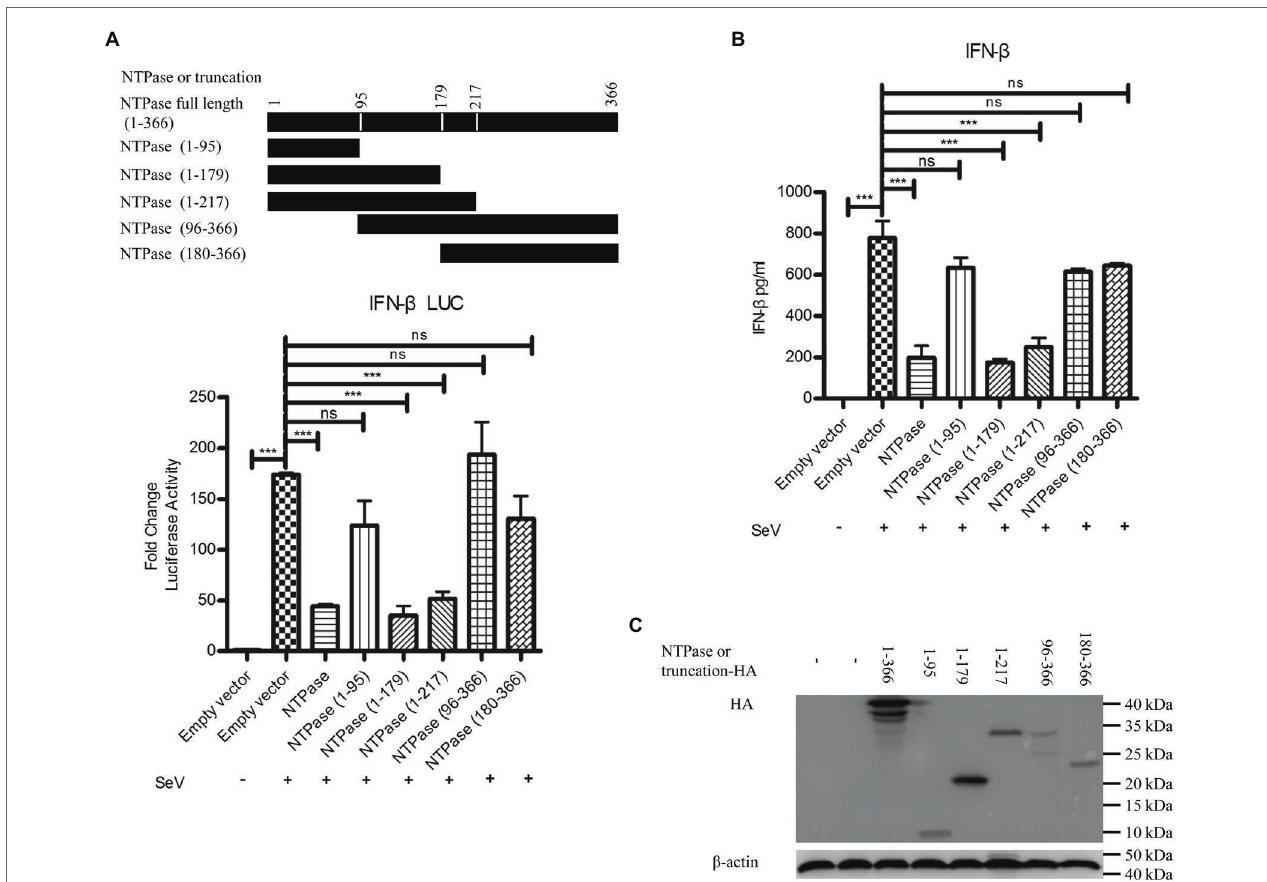
FIGURE 6 | The 1-179 aa domain of NTPase is important in inhibiting IFN- β production. (A) The 1-179 aa and 1-217 aa domains of NTPase significantly inhibit the activation of IFN- β promoter. 200 ng NTPase, truncated NTPase expression plasmid, or empty vector together with 100 ng p125-Luc and 20 ng phRL-TK was cotransfected into HEK 293T cells preseeded in 48-well plates for 24 h followed by stimulation with or without SeV for 16 h. Reporter activities were determined with DLR assay. (B) The 1-179 aa and 1-217 aa domains of NTPase inhibit the production of IFN- β . 3 μ g NTPase, truncated NTPase expression plasmid, or empty vector was transfected into HEK 293T cells preseeded in 6-well plates. At 24 h posttransfection, cells were stimulated with or without SeV for 16 h. The protein level of IFN- β in supernatants was measured by ELISA. (C) The expression of NTPase and truncated NTPase is determined by anti-HA Ab. One representative experiment out of three is shown for WB. For graphs, data shown are mean ± SD of three independent experiments, with each condition performed in triplicate. *** p < 0.001; ns, not